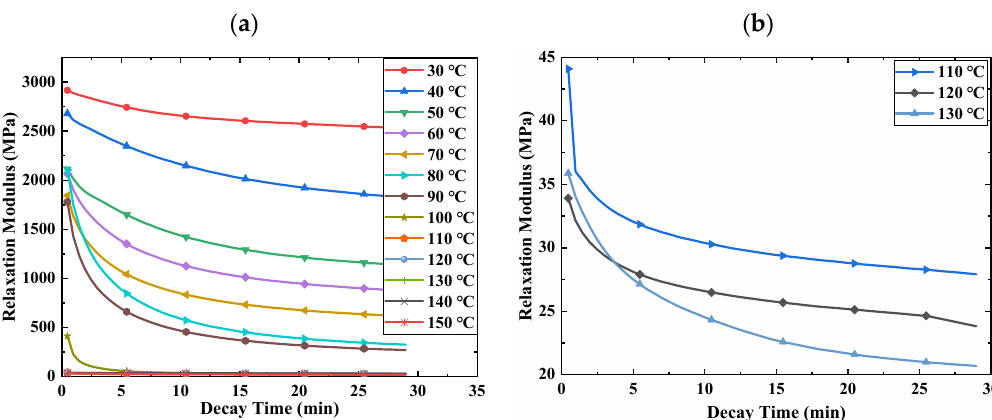
Figure 2. Relaxation test curves under different test temperatures: ( a ) relaxation test curves under different temperatures; ( b ) relaxation test curves under high temperatures.